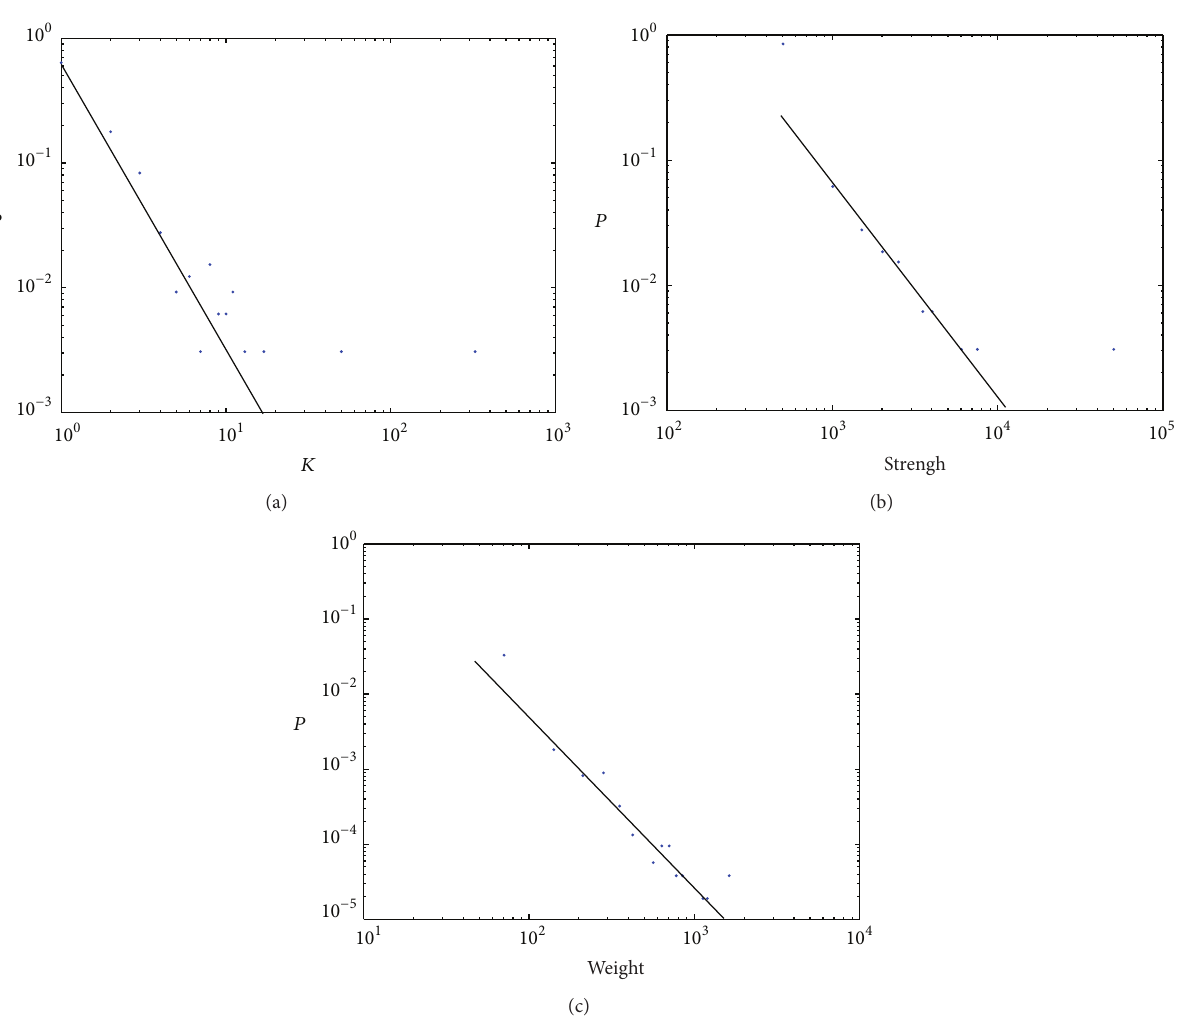
Figure 2: Topological property for TD Lee scientist cooperation network. (a) Node degree distribution; (b) node strength distribution; (c) edge weight distribution.